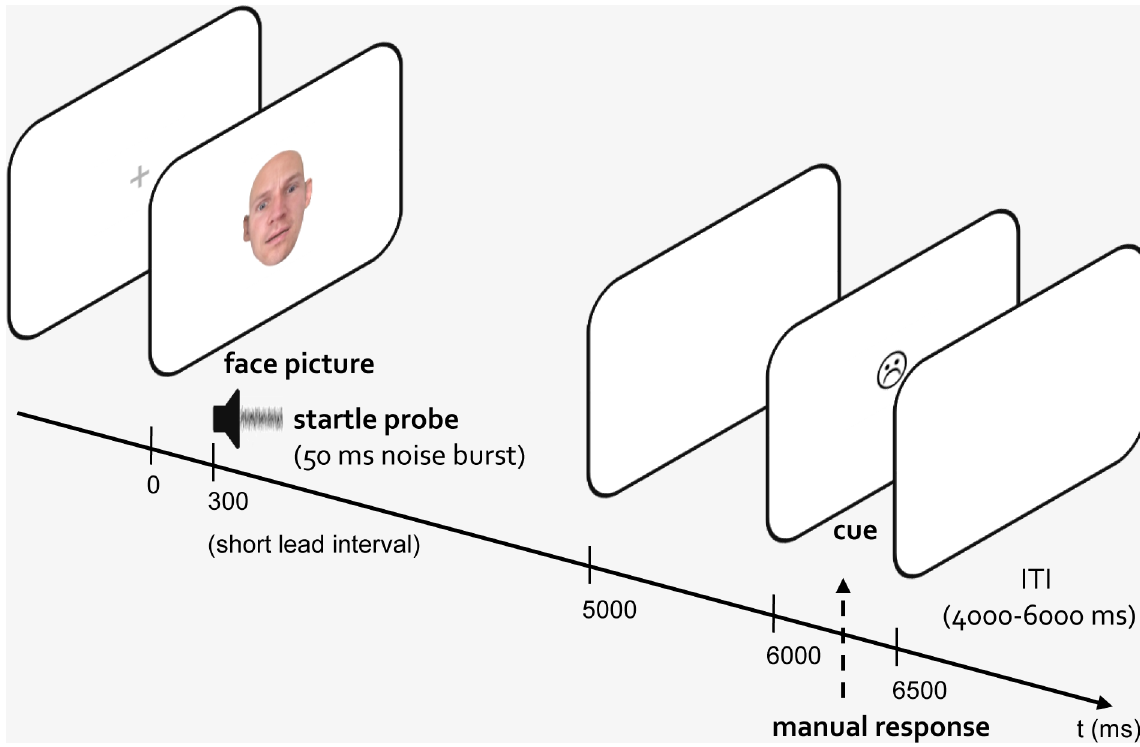
Fig 1. Structure of an example trial. After a delay of either 300 ms (short lead interval) or 3500–4500 ms (long lead interval) relative to picture onset, startle was elicited by a 50-ms burst of white noise (startle probe). In one third of trials no startle probe was presented. After picture offset, participants had to respondto a smiley symbol (response cue) by indicating a match or mismatch to the expressionof the precedingface picture. ITI: Inter-trial interval. (The individualswhose photographswere used for the morphed image shown in this picture have given written informed consent, as outlinedin PLOS consent form, to publishthese details).